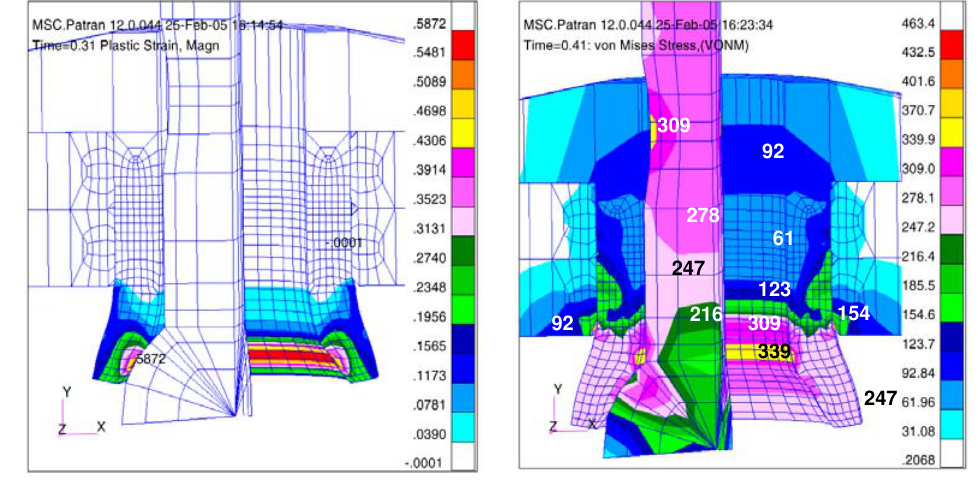
Fig 4. The plastic strain (a) and Von Mises stress (b) distribution in the early stage have riveting (for displacement of core: 0.6 mm)